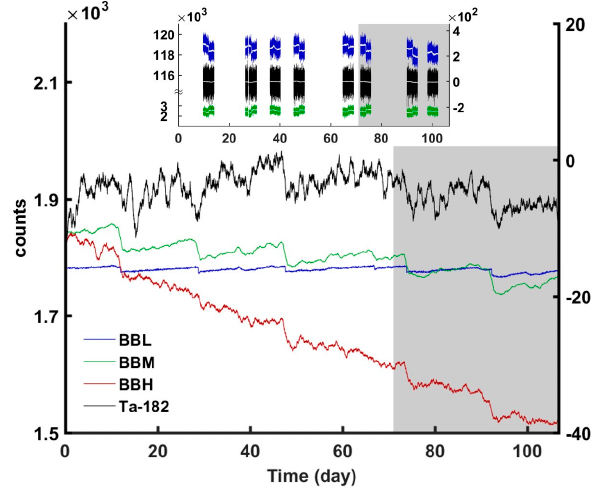
Figure 5. Fluctuations of 182 Ta γ s and broad-band γ s. The right-hand axis shows fluctuation of total counts of γ s at 1121, 1189, 1221, and 1231 keV, which are collected to represent the 182 Ta decay. Note that counts of 182 Ta γ s were less than the calibrated baseline. The left-hand axis shows counts of 0.015 × BBL, BBM, and 10 × BBH, which represent three broad-band γ s below 662 keV, between 662 and 1121 keV, and above 1121 keV. Fluctuations in these are presented against calibrated baselines, as detailed in the Supplementary Information. BBL incorporates hourly smoothing, while BBM, BBH, and 182 Ta γ s incorporate daily smoothing. An inset diagram gives raw and smoothed (white) data of the Sisyphus falls. Air conditioners were turned off after day 71, indicated by the gray area.